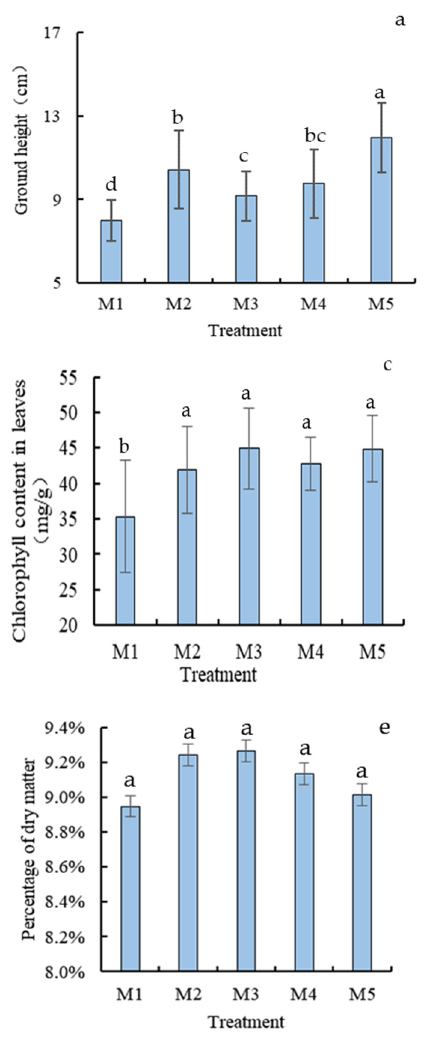
Figure 3. Ground height ( a ), root length ( b ), Chlorophyll content ( c ), biomass ( d ) and percentage of dry matter ( e ) of Chinese cabbage under different treatments at harvest (60 days). Different letters in the same column indicate statistically significant differences among the samples based on one-way ANOVA (LSD, p < 0.05).